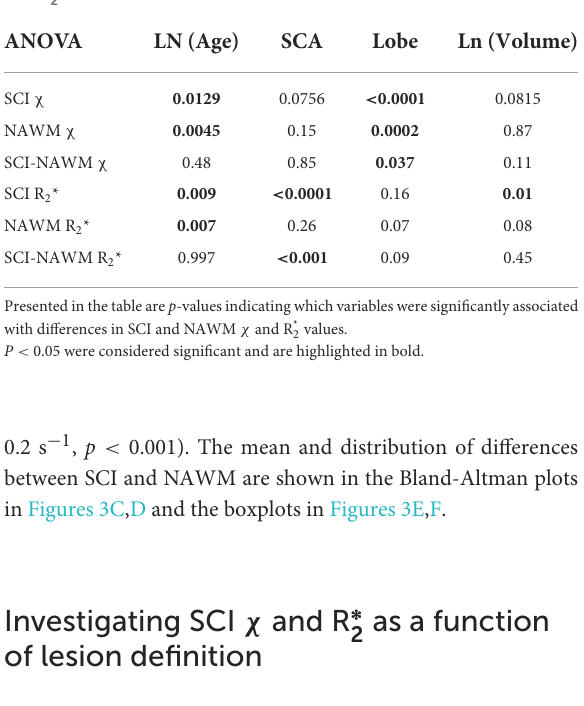
TABLE 1 Overview of participant and lesion characteristics in patients with sickle cell anemia (SCA) and healthy controls (HC). Participants SCA HC P 32